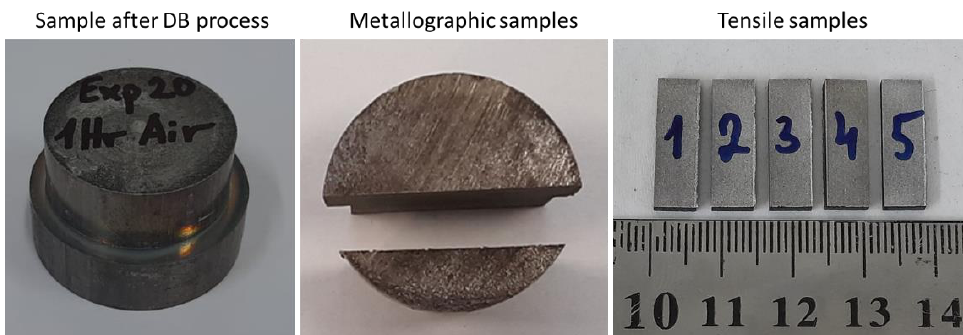
Figure 5. Samples after DB experiment and EDM cut for tensile and metallographic characterizations.